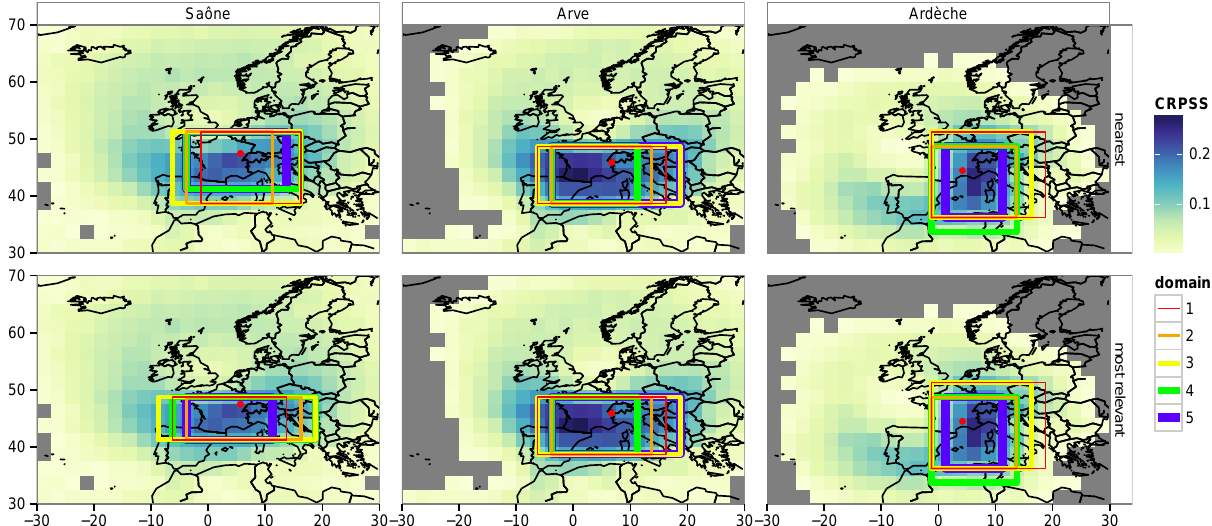
Fig. 8. Optimised predictor domains for three case study zones and different starting domains for the optimisation. First row, start at the nearest elementary domain; second row, start from the most relevant elementary domain from the relevance map. The relevance maps for each zone are shown with a colour scale underneath the predictor domains.